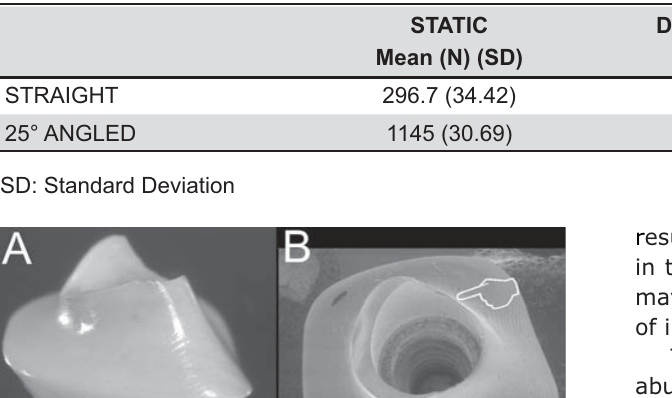
Table 1- Mean values for mechanical testing of the straight and 25° angled zirconia abutment groups